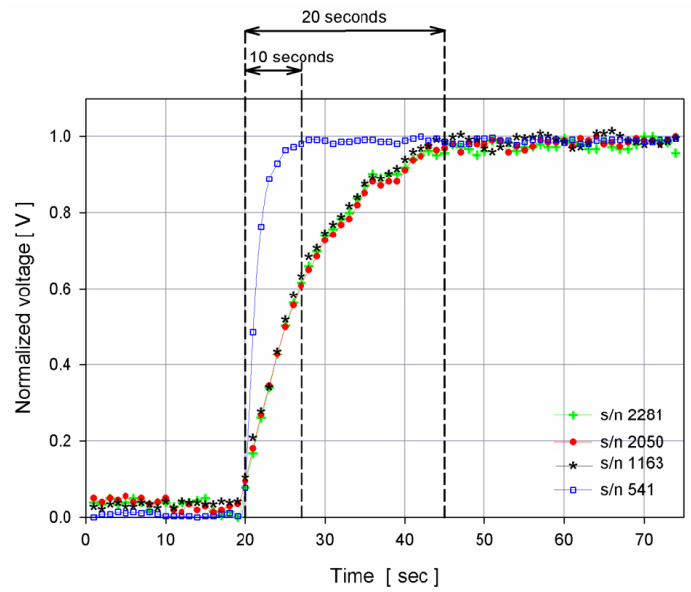
Figure 4. Response time of dissolved oxygen SBE43 sensors at a stabilized temperature of 15 °C.